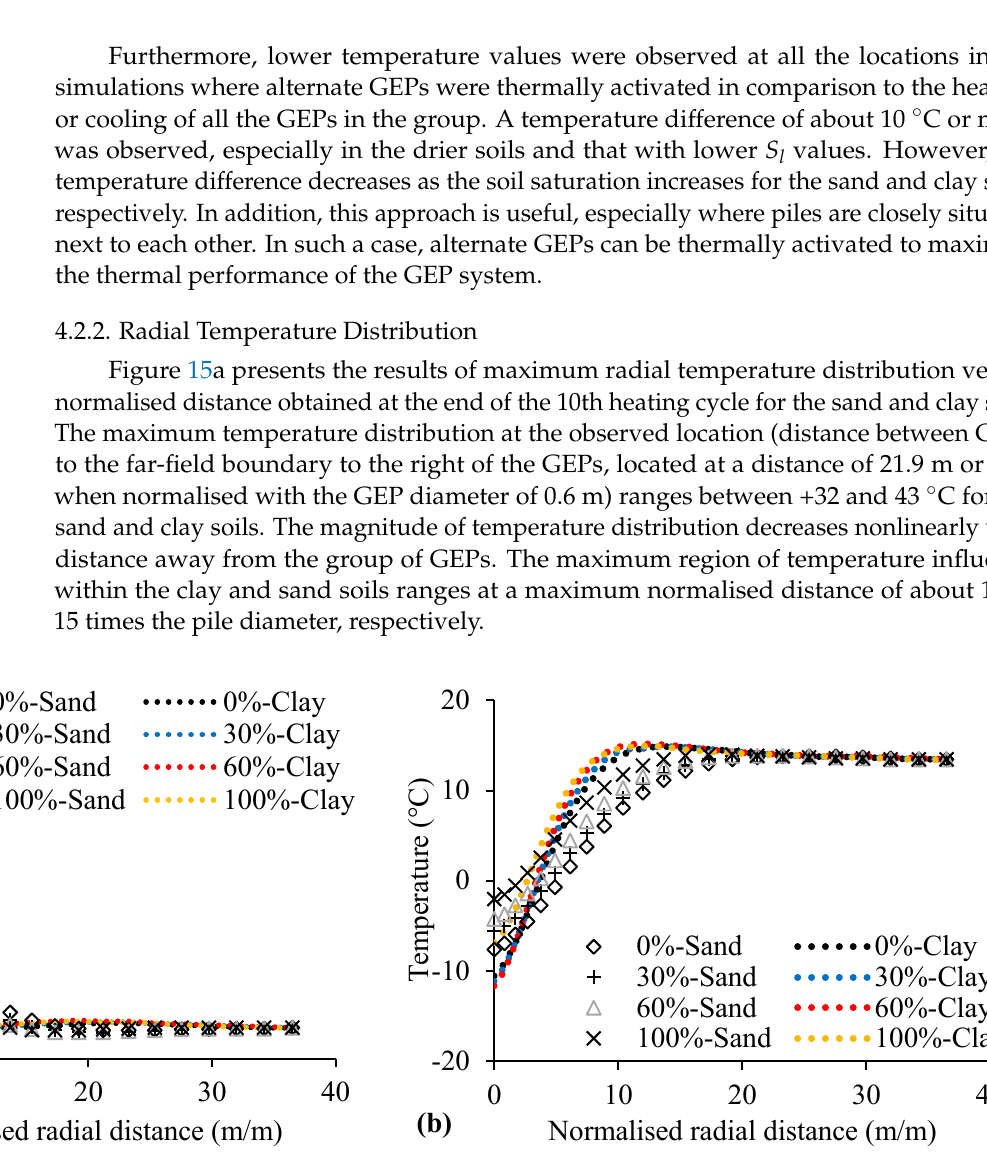
Figure 15. The radial temperature distribution with a normalised distance at the end of 10th cycle: ( a ) maximum and ( b ) minimum .